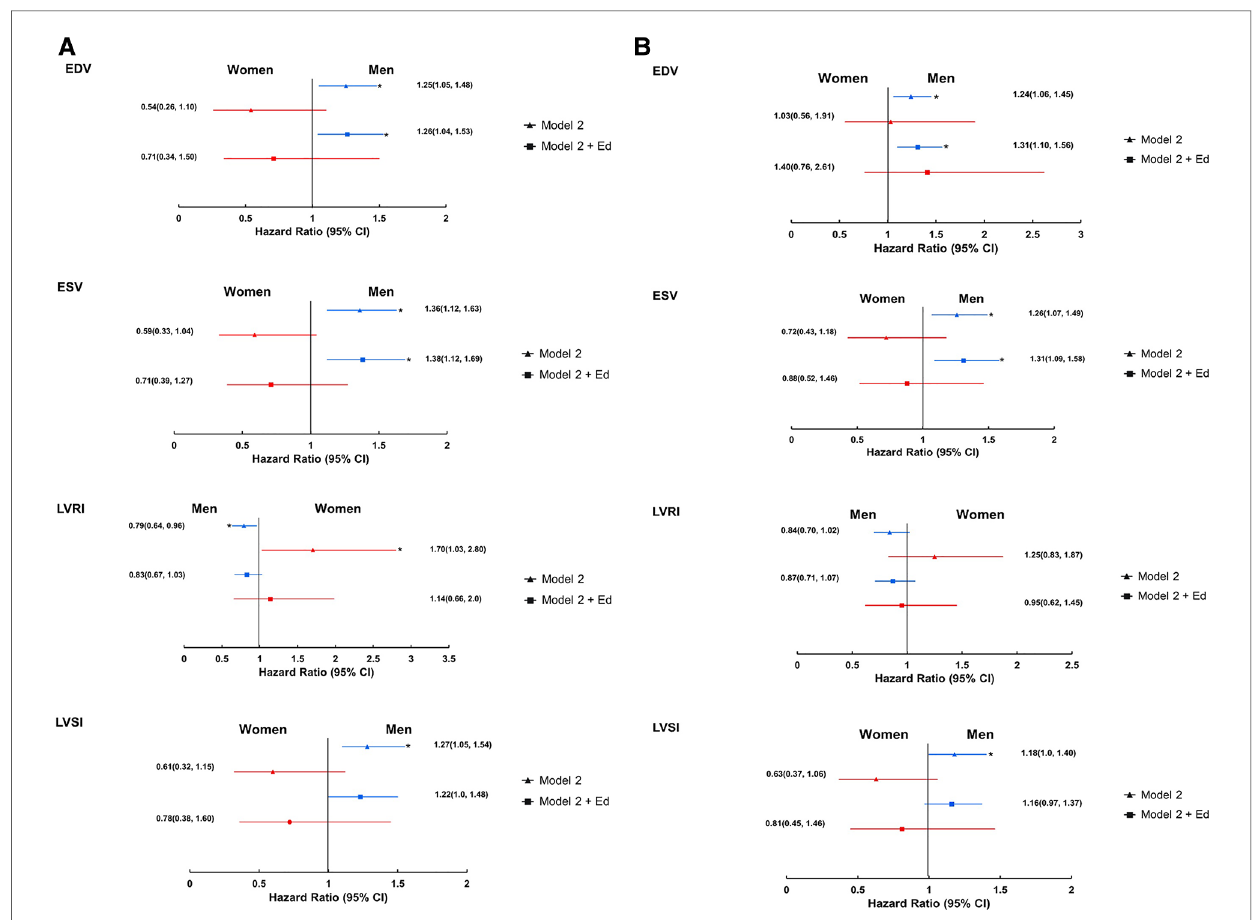
Table S4 ) had minimal effects on